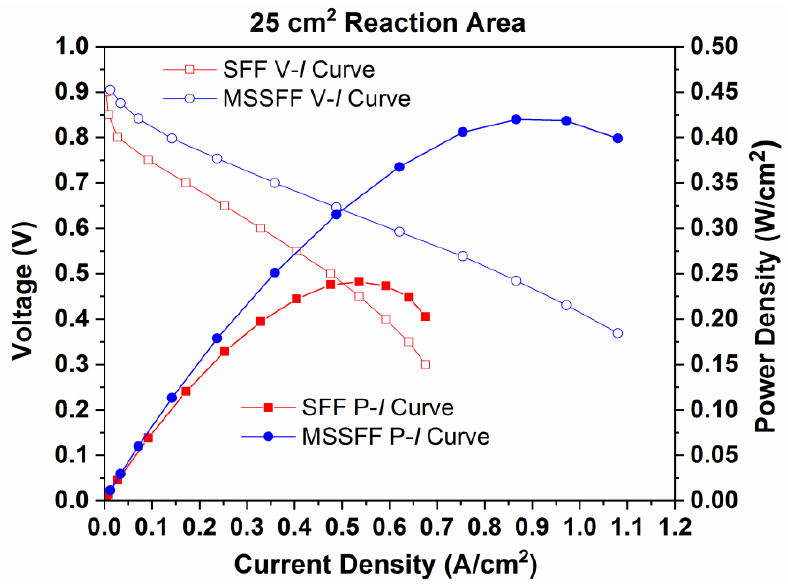
Figure 6. Performance (P–I) curves and Polarization (V–I) curves for SFF and MSSFF on cathode side with 25 cm 2 reaction area.